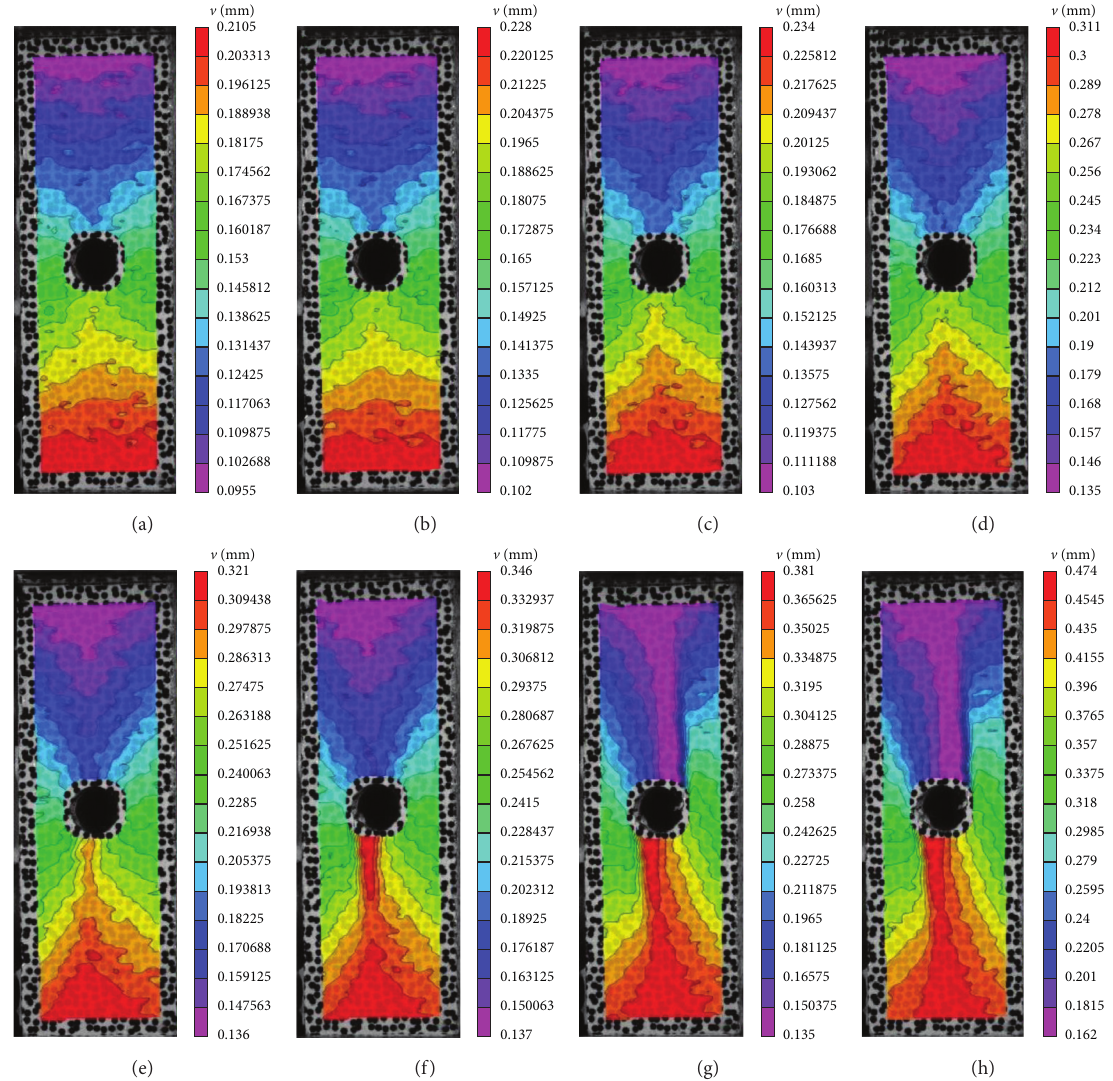
Figure 14: The nephogram of the vertical displacement field at different stress levels corresponding to points A–H in Figure opening. The stress acting on the specimen is still increasing, the stress concentration area at point A is approximately but the peak strength of the specimen has not yet been 2.16 × 10 − 3 , which is far greater than the critical tensile strain, reached, implying that macroscopic fracture of the sample indicating that point A is in the stages of tensile stress appears before reaching the peak strength. When the peak concentration and crack initiation. With increasing load, the strength is reached, the major principal strain increases to range of the stress concentration area and the value of the the maximum value of 4.46 × 10 − 2 , and a stress concentra- major principal strain further increase, and the two mac- roscopic stress concentration zones are parallel to the tion zone appears at the upper left of the opening and ex- principal stress direction (Figures 15(b)–15(d)). As the tends to the upper left corner of the sample (Figure 15(h)), loading continues, the stress concentration area directly suggesting the formation of secondary cracks. The micro- under the opening transfers to the lower left of the opening cracks on the left and right sides of the opening obviously (Figure 15(e)), which means the cracks will be initiated in the tend to develop further to the original direction, and the lower left of the opening. Subsequently, the stress concen- crack area almost penetrates the whole specimen and tration area just above the opening is transferred to the eventually evolves into macrocracks, which causes the failure upper right of the opening (Figures 15(f) and 15(g)), in- of the sample. In addition, the local tensile deformation dicating that cracks will also occur in the upper right of the concentration area generated directly above and below the cavern, which is distributed diagonally and symmetrically opening almost disappears. After the test, it is observed that with the stress concentration zone in the lower left of the the stress concentration area identified by the image